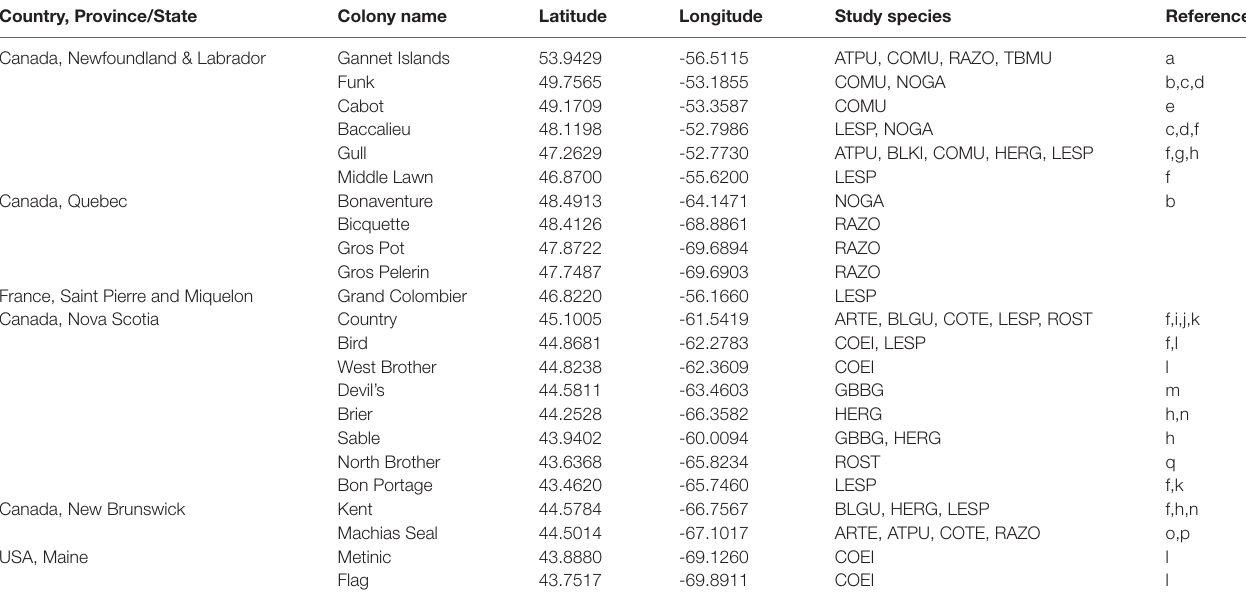
TABLE 2 | Study species and sites where tracking devices were deployed (see Table 3 for tracking